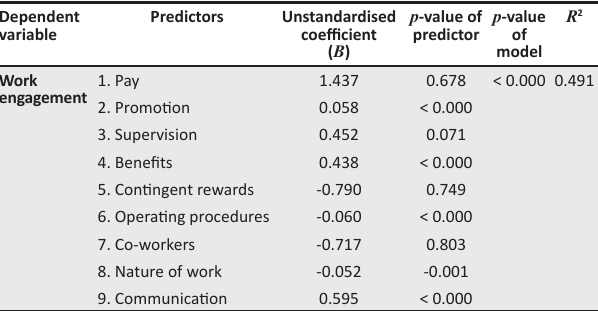
TABLE 4: Validation of hypothesis statement. Dependent variable